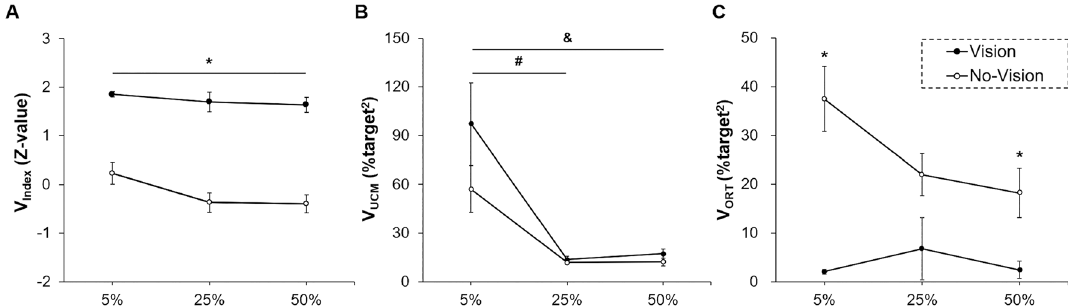
Figure 1. Bimanual coordination across multiple trials using UCM approach ( M ± SE ). ( A ) bilateral motor synergies (V Index ) showing a significant Visual Condition main effect. ( B ) Good variability (V UCM ) showing a significant Force Level main effect. ( C ) Bad variability (V ORT ) showing a significant Visual Condition × Force Level interaction. Asterisk (*) denotes a significant difference between visual conditions. Number sign (#) indicates a significant difference between 5 and 25% of MVC. Ampersand (&) means a significant difference between 5 and 50% of